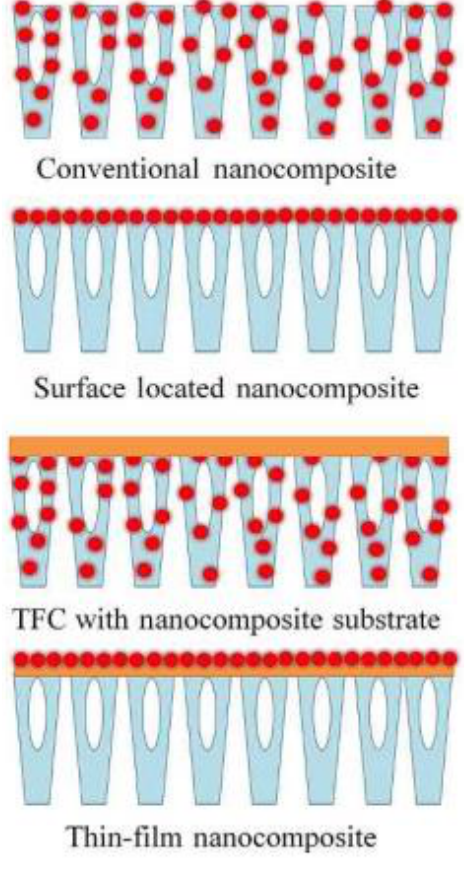
Figure 1. A diagram depicting the forms of nanocomposite membranes.